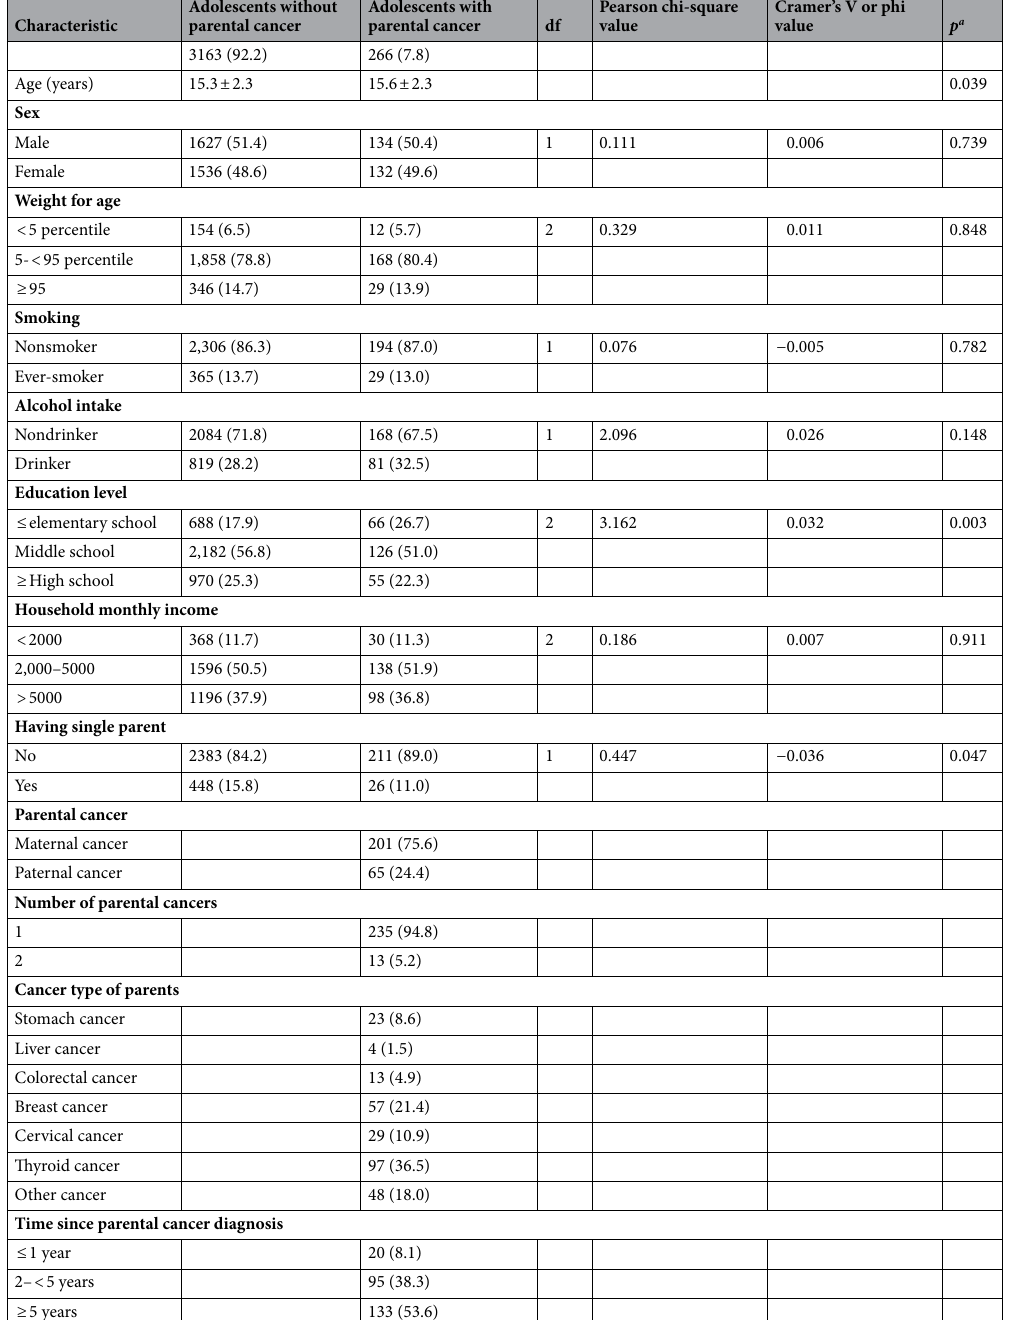
Table 1. Baseline characteristics of adolescent aged from 12 to 19 (n = 3429). Data are presented number and percentage (%) or mean ± S.D. a p value unpaired t-test for continuous variables or from chi-square test for categorical